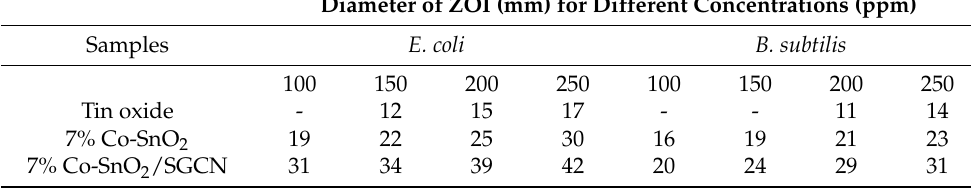
Table 4. Antibacterial activity against E. coli and B. subtilis